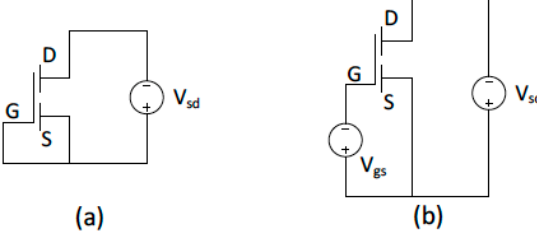
Figure 11. Two different GaN HEMT bias for the gap state of the synchronous rectifier transistors. ( a ) V GS = 0 V and ( b ) V GS < 0 V.